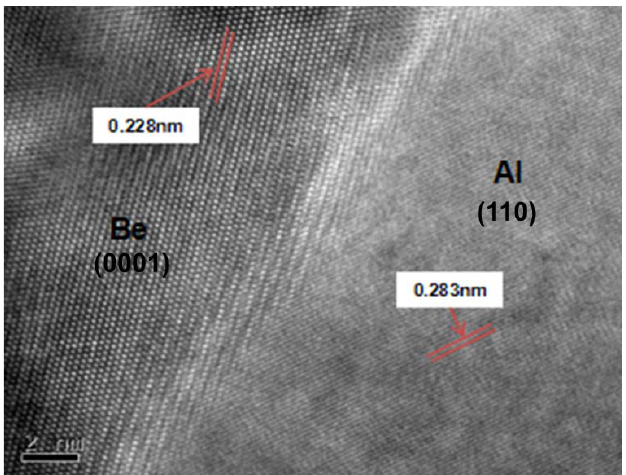
Figure 3. Bright field HRTEM images of the phase interface between Be and Al.